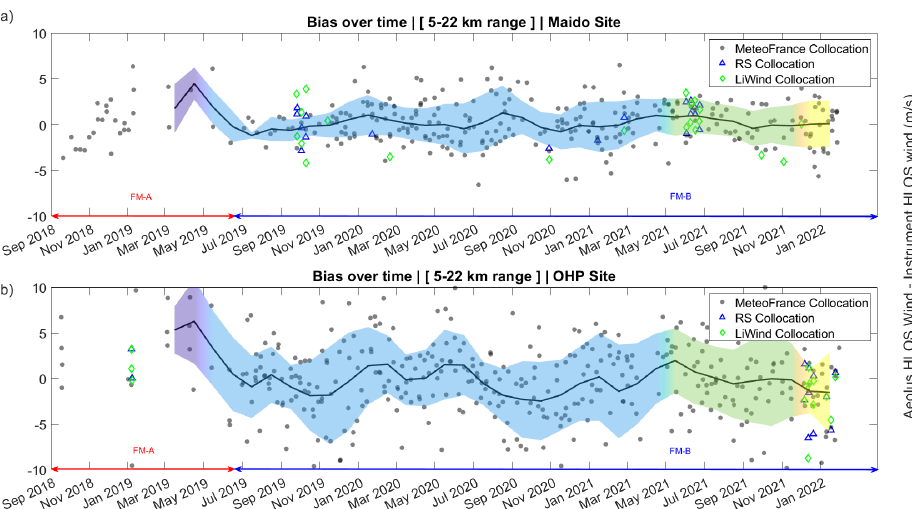
Figure 7. Bias between Aeolus Rayleigh clear HLOS wind and Météo-France radiosonde HLOS wind over time (a) at the Maido observatory and (b) at the Observatoire de Haute-Provence. The Météo-France data were downsampled to Aeolus vertical resolution and projected to the HLOS of Aeolus. For radiosonde and ground-based lidar collocations, the cal/val punctual collocations are reported in the figure in blue and green markings. The black line represents the average value, and the shading represents its standard deviation. The colors are relative to the four baselines used: 2B02 (violet), 2B11 (blue), 2B12 (green), and 2B13 (yellow), in that